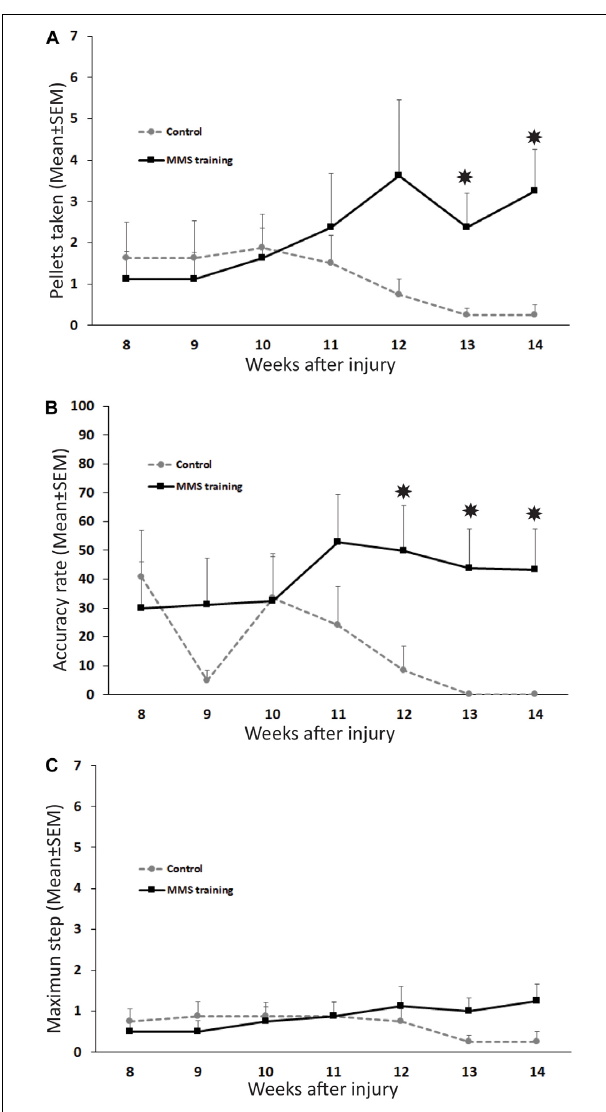
FIGURE 1 | Functional recovery in reaching and grasping after Modified Montoya Staircase (MMS) rehabilitation. After unilateral cervical spinal cord injury (SCI), all rats lost the skilled forelimb functions in the MMS test in the injury side. Rats that received MMS rehabilitation weekly starting from 8 weeks after injury took significantly more pellets than the control group at 13 and 14 weeks post-injury (PI) [ (A) , p = 0.037 and 0.021, respectively]. The number of pellets taken were significantly increased at 14 weeks PI compared to 8 weeks PI in the MMS rehabilitation group [ (A) , p = 0.038] but not in the control group, in which the difference between the same two time points was not significant [ (A) , p = 0.181]. The accuracy rate was also significantly higher in MMS rehabilitation rats compared to control ones at 12, 13, and 14 weeks PI [ (B) , p = 0.039, 0.015, and 0.0195, respectively]. The accurate rate was significantly decreased in the control group at 13 and 14 weeks PI compared to 8 weeks PI [ (B) , p = 0.007 and 0.009, respectively]. There were no significant differences at these later time points compared to 8 weeks PI in the MMS training group [ (B) , p = 0.015 and 0.0195, respectively]. In terms of maximum step reached, there was no significant difference between the MMS rehabilitation group and the control group (C) . There was no significant difference from 8 weeks PI to 13 or 14 weeks PI in both groups (C) . Results represent mean ± standard error of the mean (SEM); n = 8 in each group. * P < 0.05.